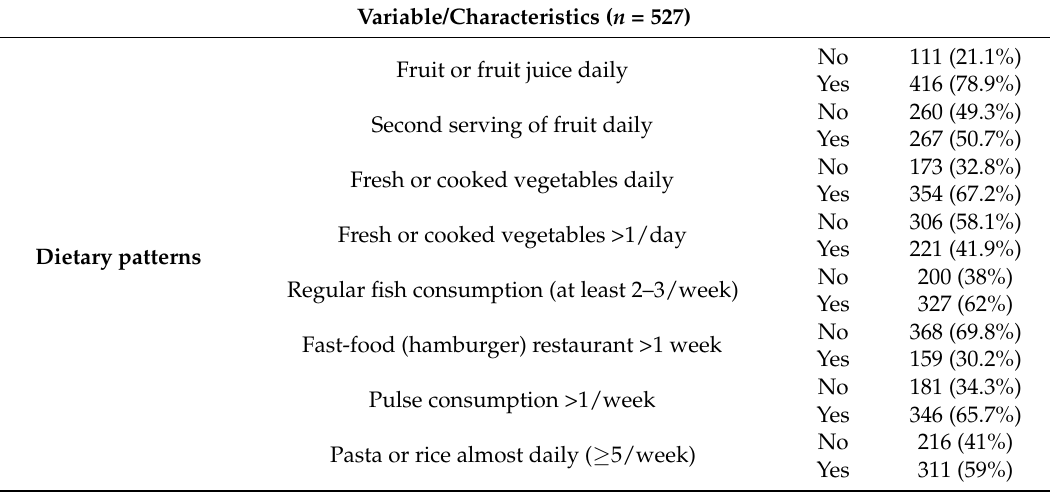
Table 1. Baseline characteristics of the sample in dietary patterns, adherence to the MD, perceived loneliness, and